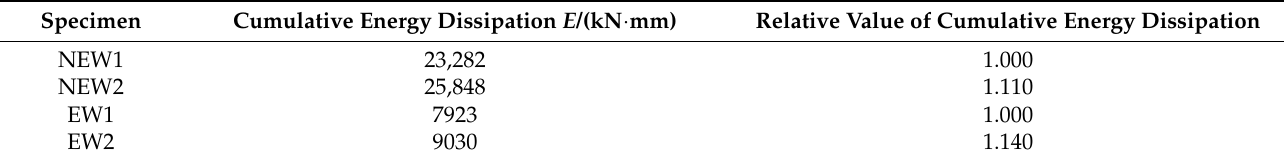
Figure 11. Accumulated energy dissipations of specimens. Table 6. Comparison of cumulative energy dissipation.